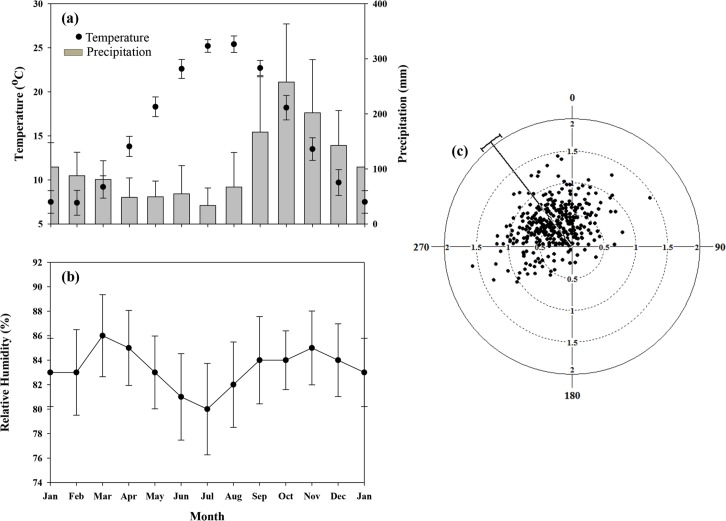
Climatological summaries for Noushahr station.(a) air temperature (°C), precipitation (mm), (b) relative humidity (%), and (c) wind velocity (m s-1) and direction (° from true north) based on climate data recorded from 1977 through 2005. The bars in all instances represent the level of data dispersion for individual variables. Mean annual wind direction is 322.1° (±47.9°, standard deviation) from true north; its value varies to 332.6° (±37.5°) during the growing period. Near-surface growing-period average wind velocity is about 0.64 m s-1 (±0.28 m s-1).